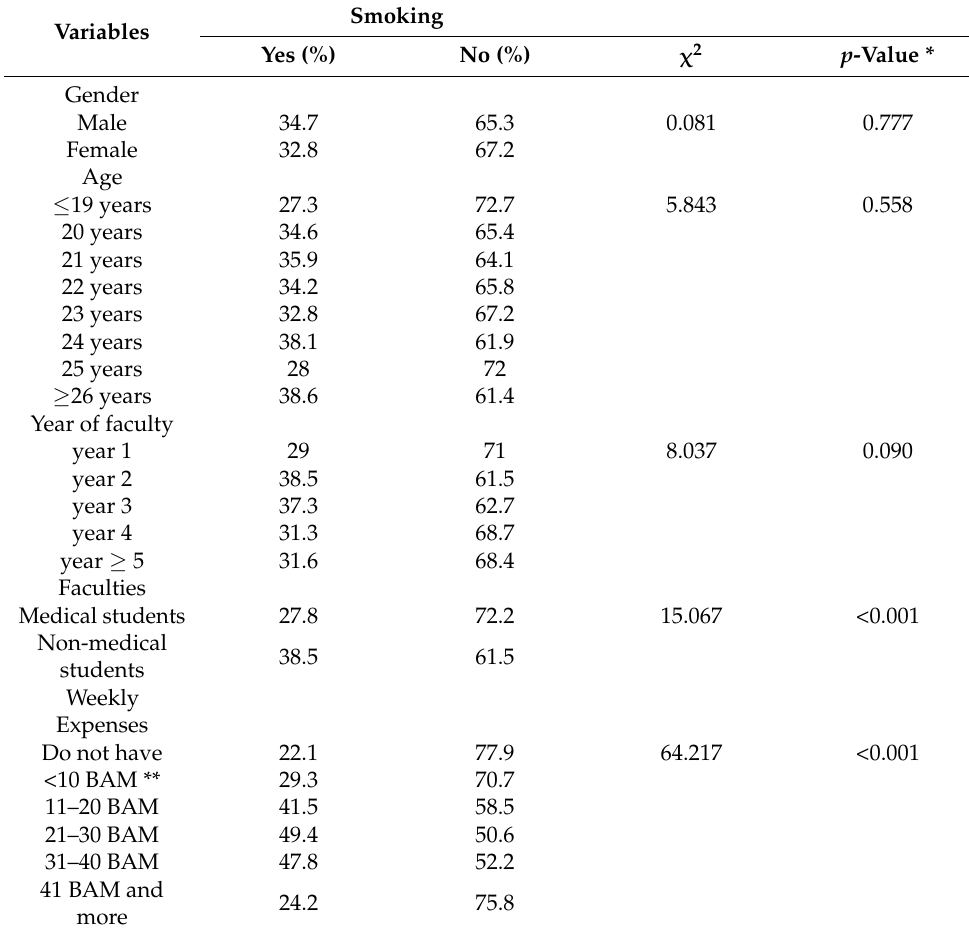
Table 1. Students’ smoking status and socio-demographic